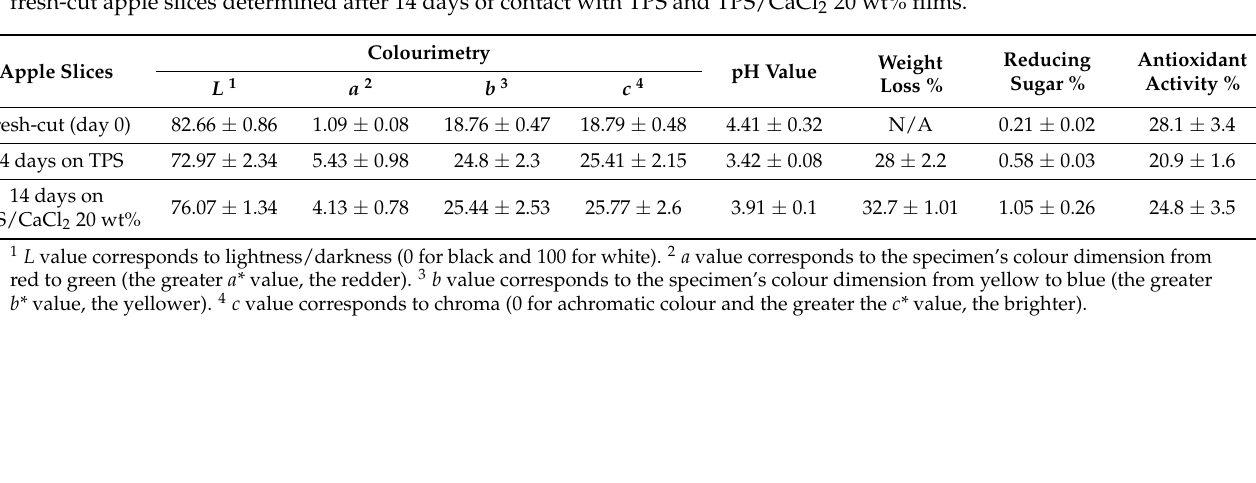
Figure 4. SEM micrographs of ( a ) virgin TPS, ( b ) TPS/CaCl 2 10 wt% and ( c ) TPS/CaCl 2 20 wt% com- posite films. composite films.